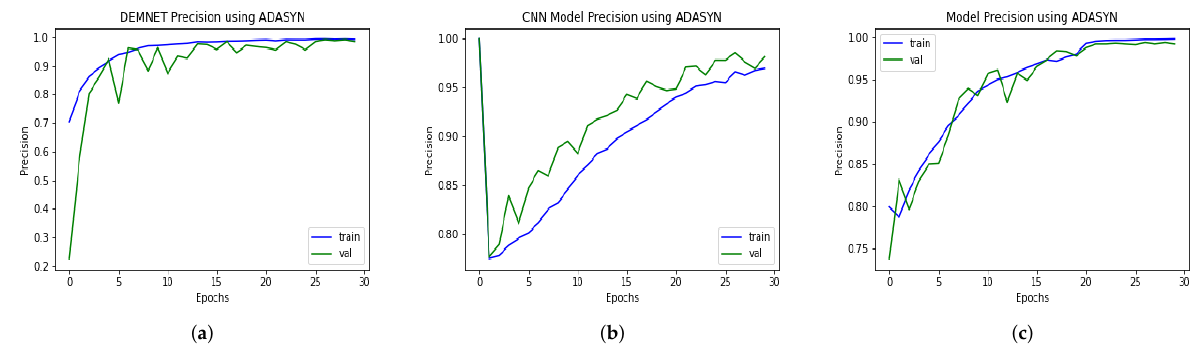
Figure 16. Precision Comparison of DEMNET, CNN Model, and DAD-Net using ADASYN. ( a ) DEM- NET; ( b ) CNN Model; ( c ) Proposed DAD-Net.